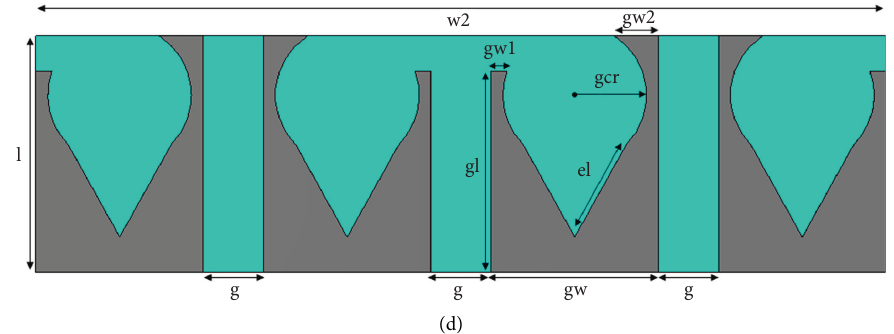
Figure 3: Array four (a, b) top view and (c, d) bottom view.(a) View from the top. (b) Front view (schematic diagram). (c) Back view. (d) Back view (schematic diagram). Table 4: Array 4 dimensions. S.